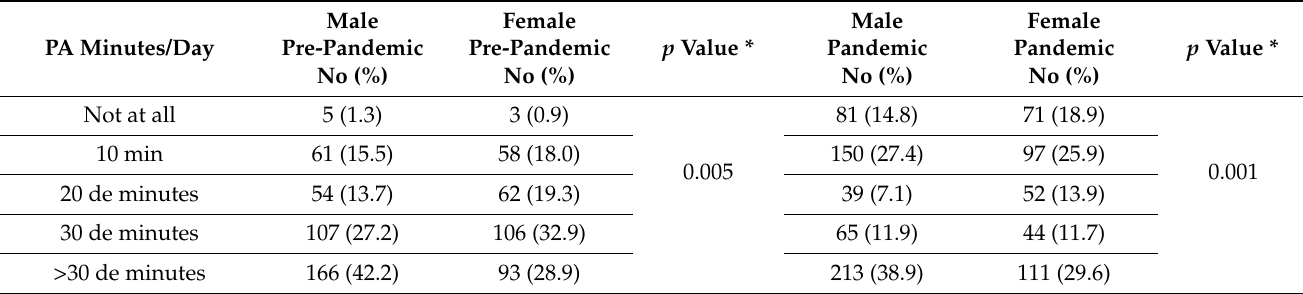
Table 7. Physical activity duration per day.